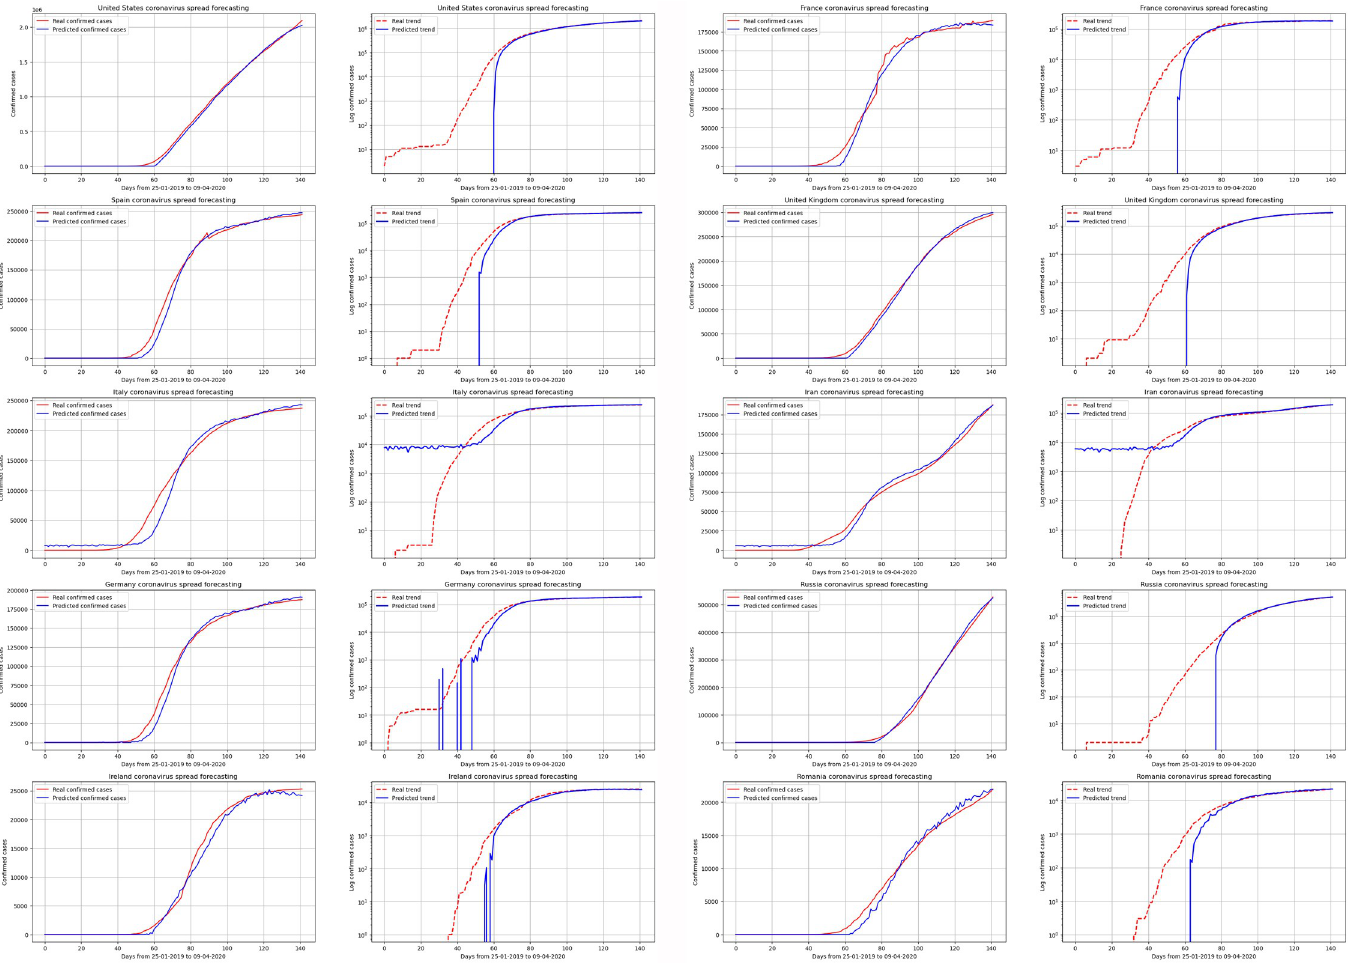
Fig 11. Model prediction and ground truth for selected countries with three timestamps and one predicted step (the period between 25/01/2020 to 14/06/2020).